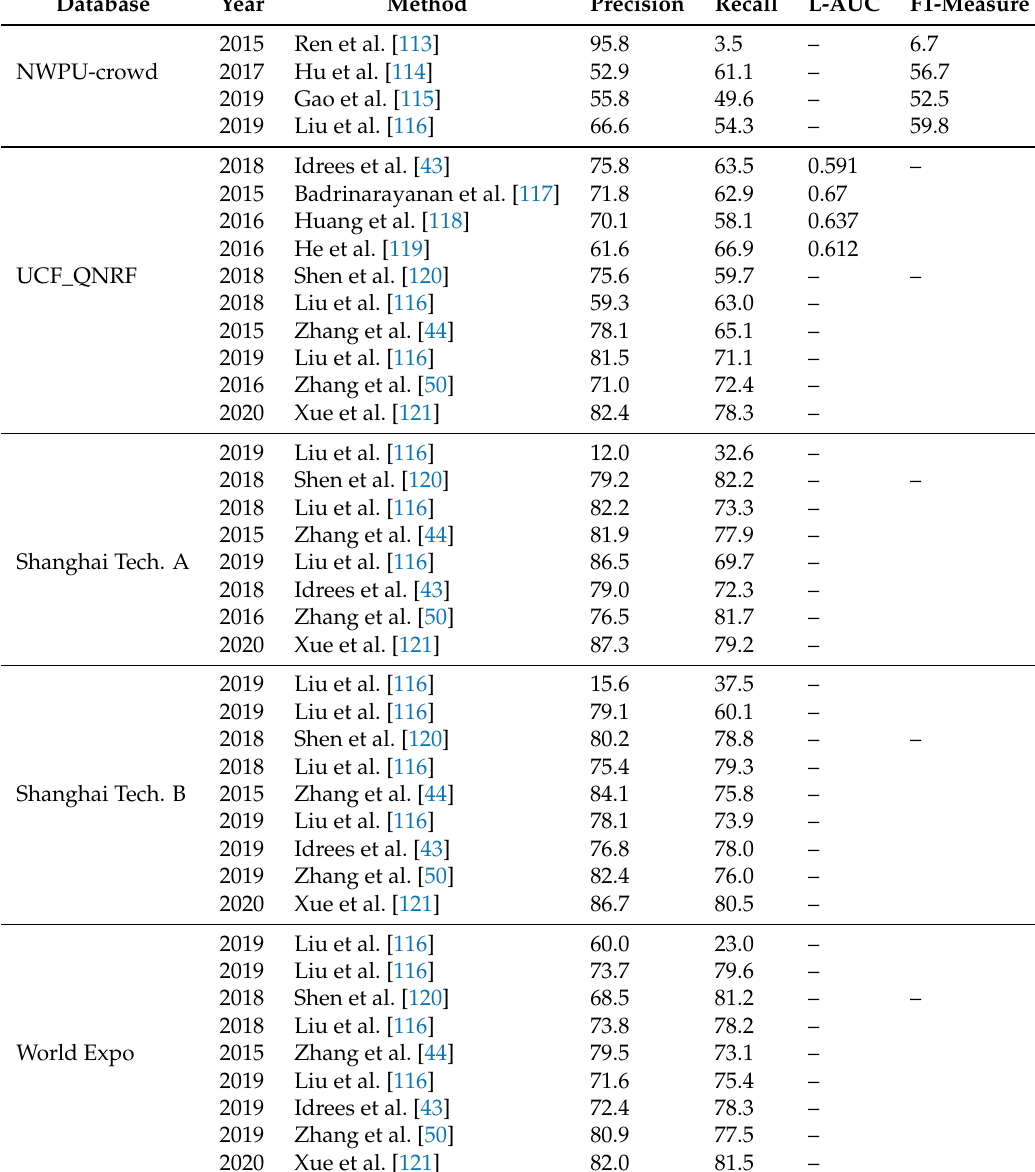
Table 2. CMS performance in the form of Average Precision, Recall, F1-measure, and AUC metrics.